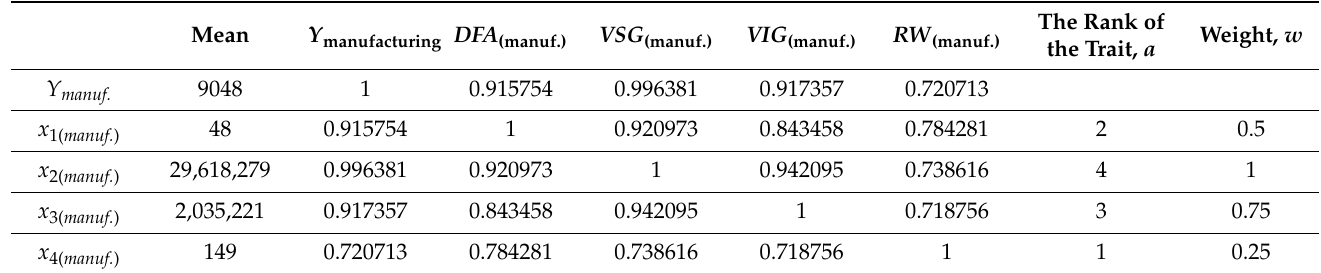
Table 2. Correlation matrix and ranking indicators the manufacturing sector of the economy.